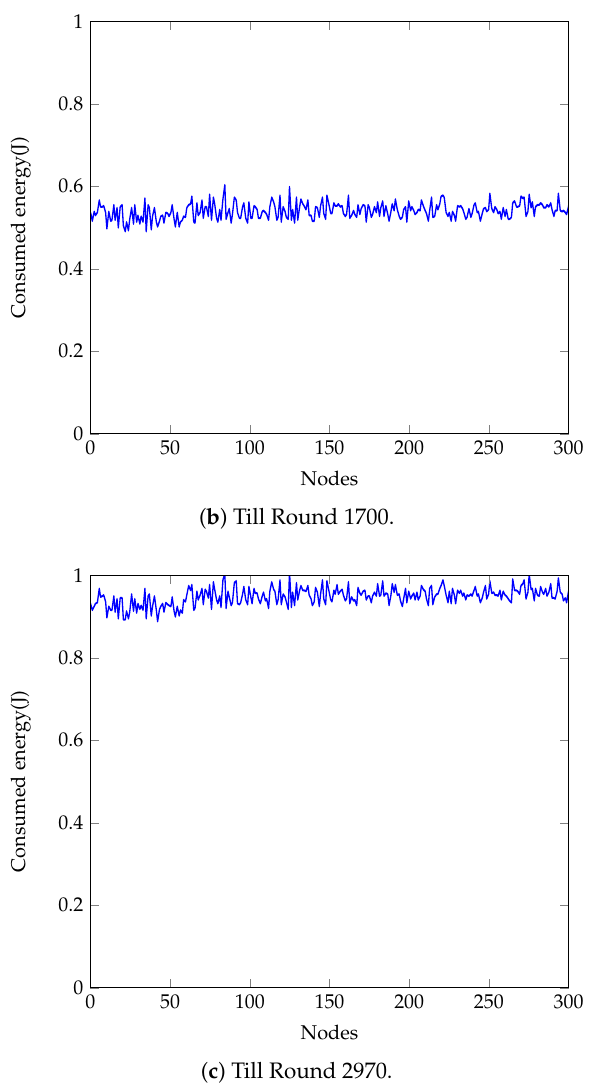
Figure 7. Energy consumption till different Rounds of the proposed approach. Table 5. Nodes energy consumption with the approach proposed in Ref.